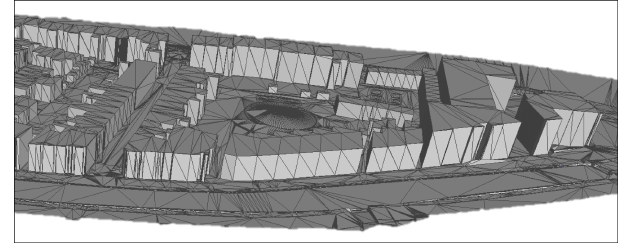
Figure 2: 3D TIN terrain model of the study area